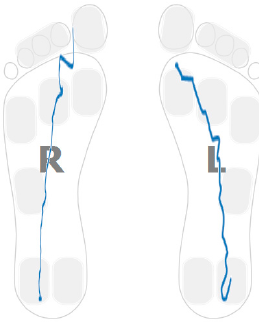
Figure 4. Healthy control.